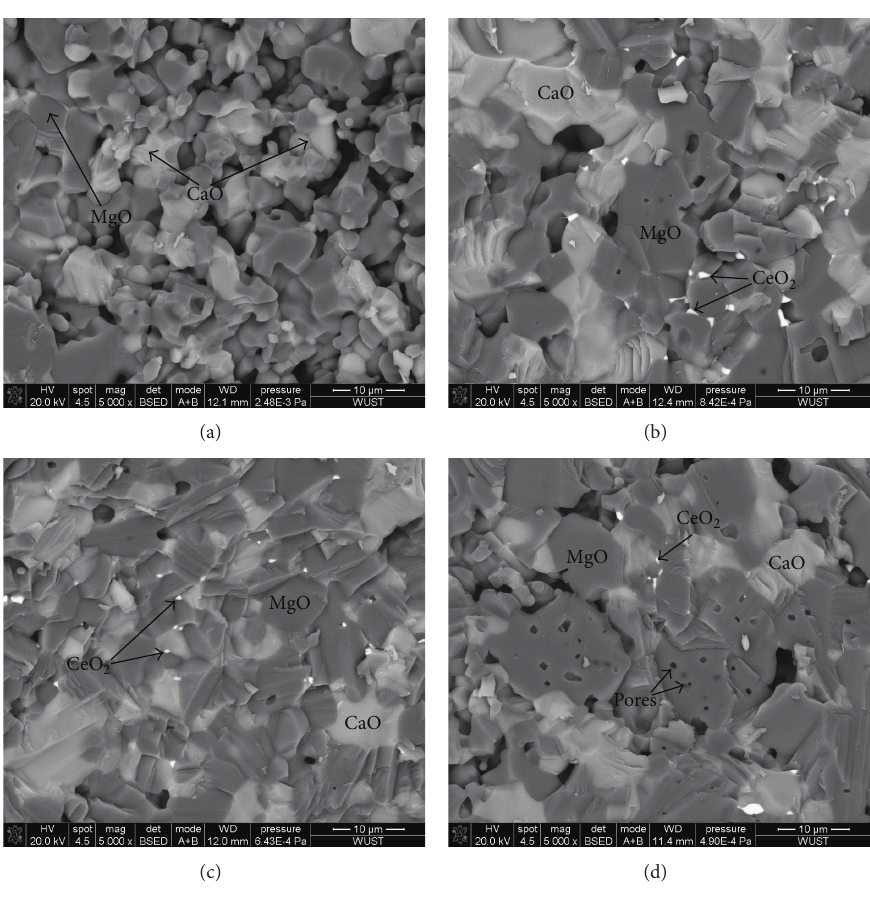
Figure 3: SEM images of samples: (a) 0%, (b) 0.5wt%, (c) 0.75 wt%, and (d) 1wt%.